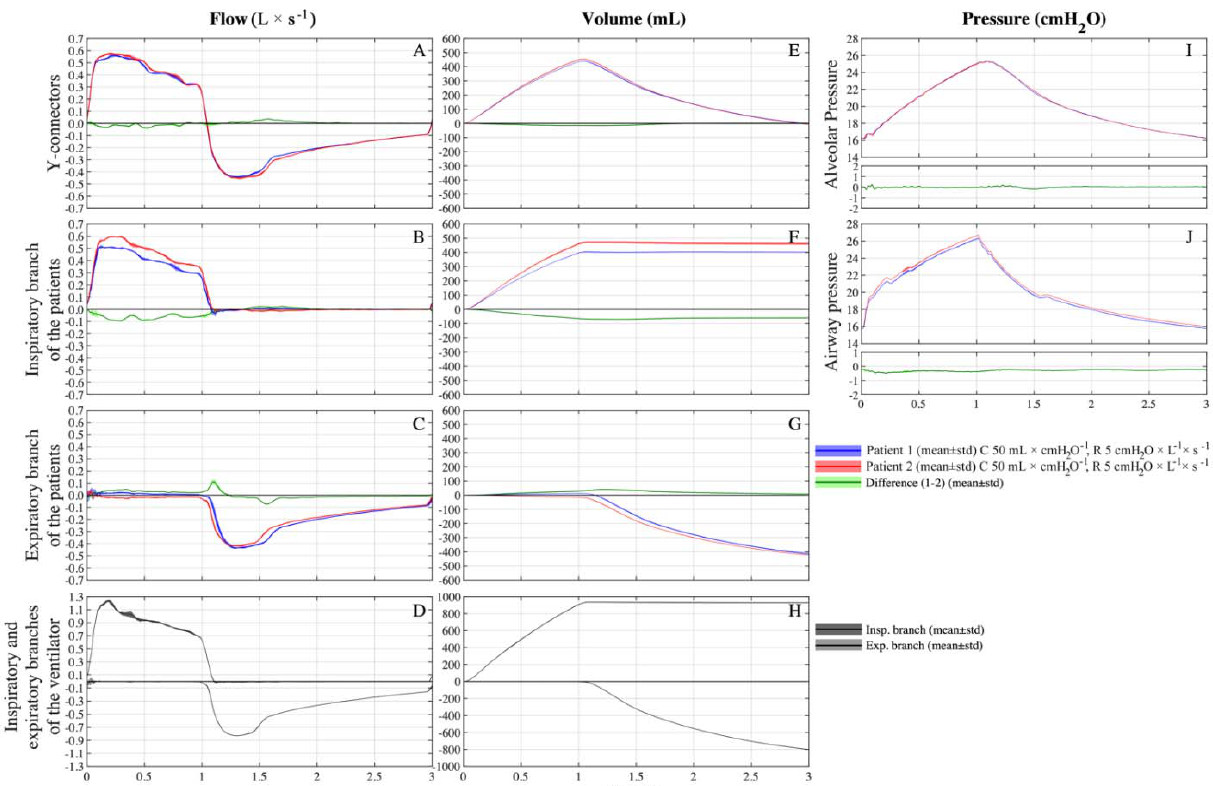
Figure 2. Average (continuous line) ± standard deviation (filled area plot) of multiple breaths of flows, pressures and volumes across the custom-made circuit on setting C 50-50/R 5-5 (C = 50 mL × cmH 2 O − 1 and R = 5 cmH 2 O × L − 1 × s − 1 for both patients). Blue = patient 1, red = patient 2; green = difference between patient 1 and 2; dark grey = inspiratory branch of the ventilator, light grey = expiratory branch of the ventilator. ( A ) Flows at Y-connectors. ( B ) Flows at inspiratory branch of patients. ( C ) Flows at expiratory branch of patients. ( D ) Flows at inspiratory and expiratory branches of ventilator. ( E ) Volumes at Y-connectors. ( F ) Volumes at inspiratory branch of patients. ( G ) Volumes at expiratory branch of patients. ( H ) Volumes at inspiratory and expiratory branches of ventilator. ( I ) Alveolar pressures. ( J ) Airways pressures at HME.